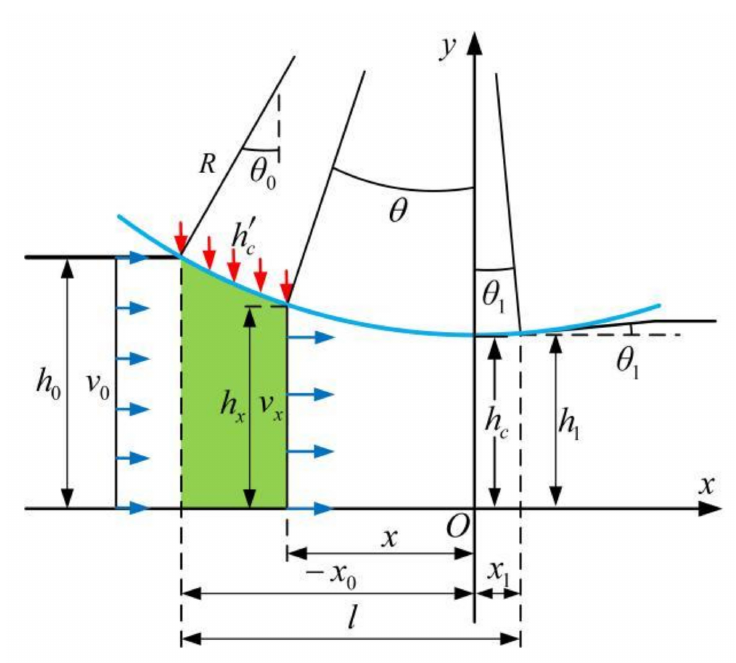
Figure 3. Conservation of metal mass in dynamic deformation